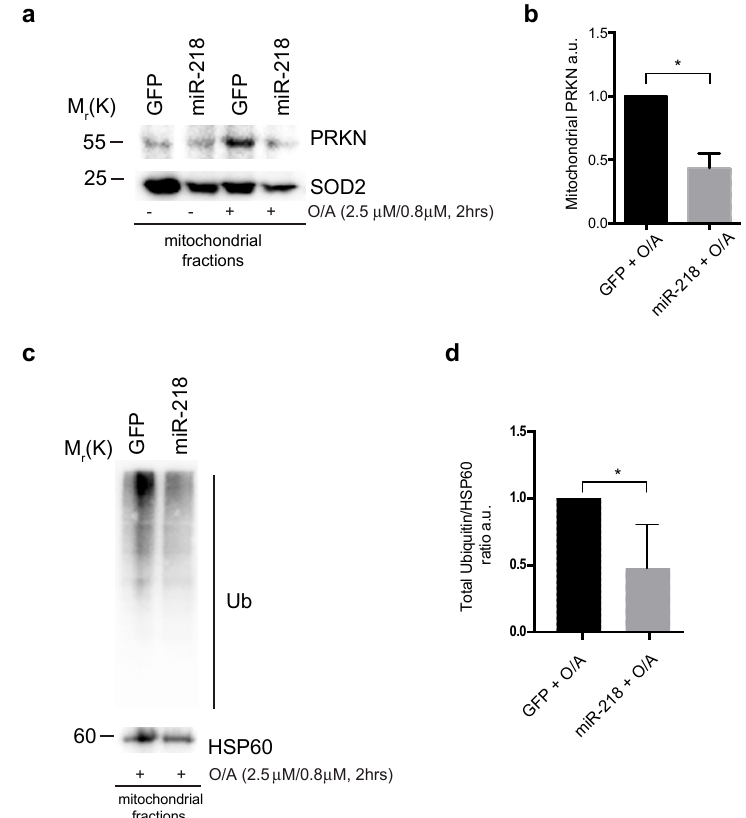
Figure 3. ( a ) HEK293 cells overexpressing GFP or GFP-miR-218 vectors were treated with O / A for 2 h and subjected to mitochondria purification. ( b ) The graph shows the mitochondrial PRKN normalized on the mitochondrial loading control. ( c ) Representative image of HEK293 cells transfected with GFP or GFP-miR-218 constructs and treated with O / A for 2 h in order to analyze total ubiquitin amount in mitochondria. ( d ) The graph shows total Ub (Ubiquitin) normalized on the mitochondrial protein HSP60 (Heat Shock Protein 60). All data represent the mean of three experiments ( ± s.e.m.). * p < 0.05. Statistical analysis was performed using Student t-test with Welch’s correction. Mr(K) = relative molecular mass expressed in Kilo Dalton.